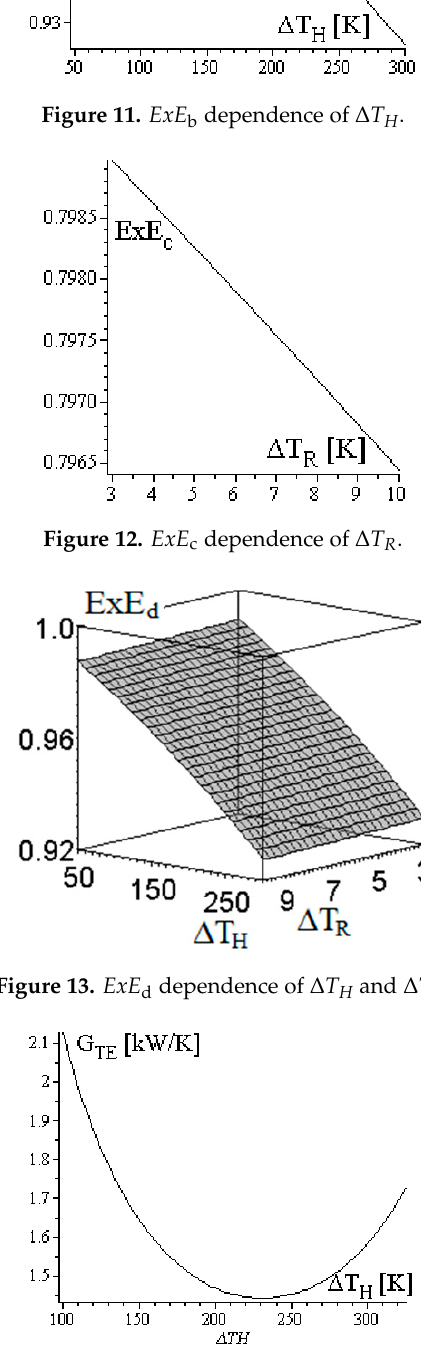
Figure 15. G TR dependence of Δ T R —case “a”. G TRmin = 2.975 kW/K for Δ T R = 6.72 K. Figure 16. G TE dependence of Δ T H —case “b”. G TEmin = 1.296 for Δ TH = 257 K. Figure 17. G TR dependence of Δ T R —case “b”. G TRmin = 2.832 for Δ T R = 7.06 K.